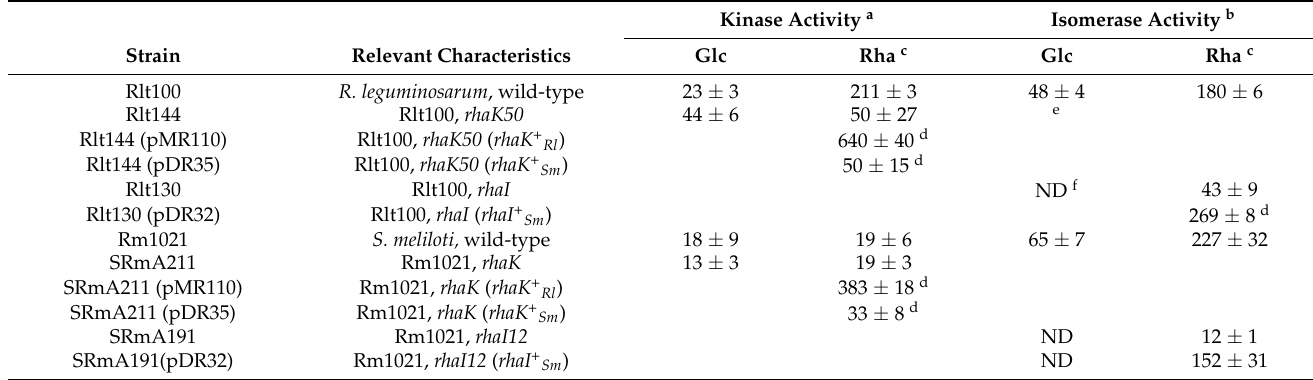
Table 4. Kinase and isomerase activity of R. leguminosarum and S. meliloti strains. Kinase Activity